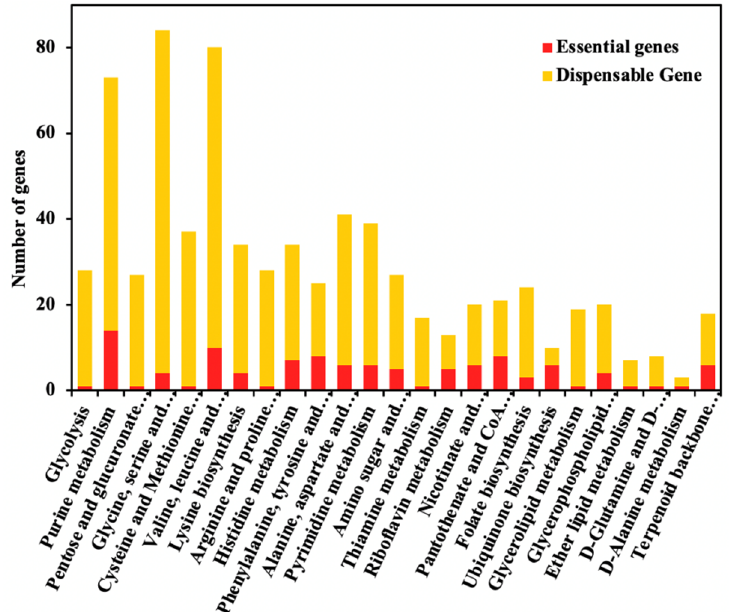
Figure 3. The essential genes (red) and dispensable genes (yellow) were classified in the KEGG